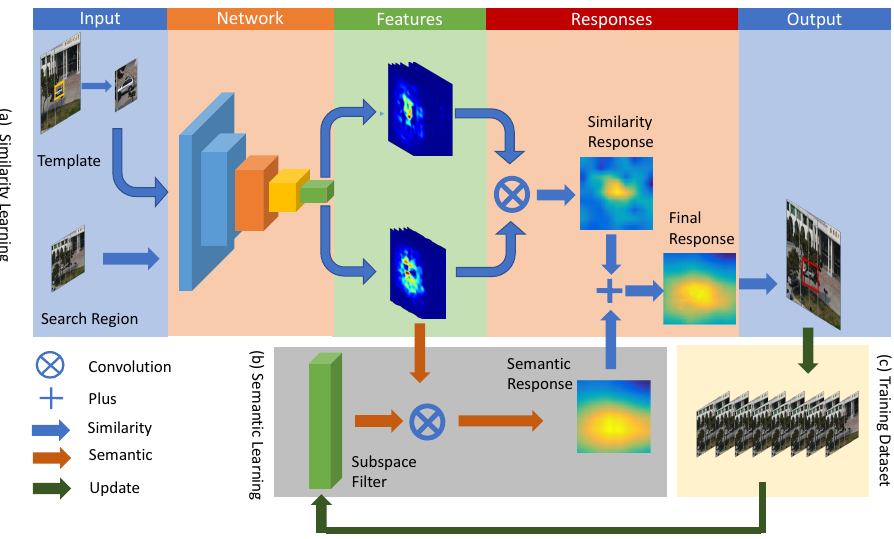
Figure 2. The pipeline of the proposed method. ( a ) The similarity response that is achieved by convoluting the CNN features driven from the Siamese network, where the inputs are the initial template and search region. ( b ) The semantic response that is obtained by convoluting the subspace filter and the search region. The final response is combined with these two responses (similarity and semantic responses) to indicate the location of the target. ( c ) The tracking results are then fed into the training dataset that is used to update the subspace filter online. Here, the blue, orange, and green lines represent similarity learning, semantic learning, and updating flows,